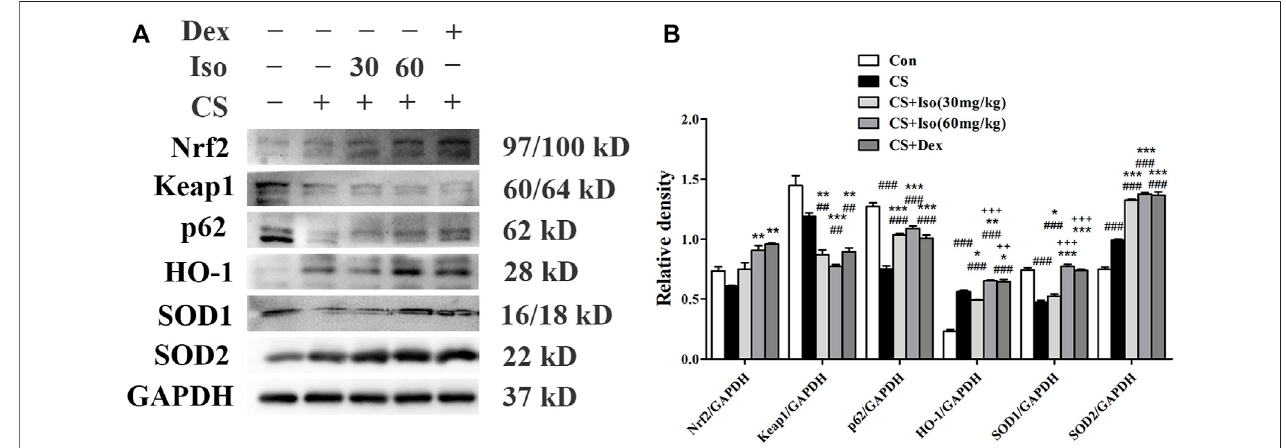
FIGURE9| IsoregulatestheNrf2/Keap1pathwayinCS-inducedCOPDmice. (A) TheproteinexpressionlevelsofNrf2,Keap1,p62,HO-1,SOD1,andSOD2were measured by western blotting, respectively. GAPDH was used as the internal reference. (B) The band intensities of Nrf2, Keap1, p62, HO-1, SOD1, and SOD2 were semiquanti fi ed using ImageJ ( n = 3 mice per group). Data was shown as mean (±SD) (B) . To test for group differencses one-way ANOVA (B) was applied. ## p < 0.01, ### p < 0.001 vs. control group, * p < 0.05, ** p < 0.01, *** p < 0.001 vs. CS group and ++ p < 0.01, +++ p < 0.001 vs. CS + Iso 30 mg/kg group.